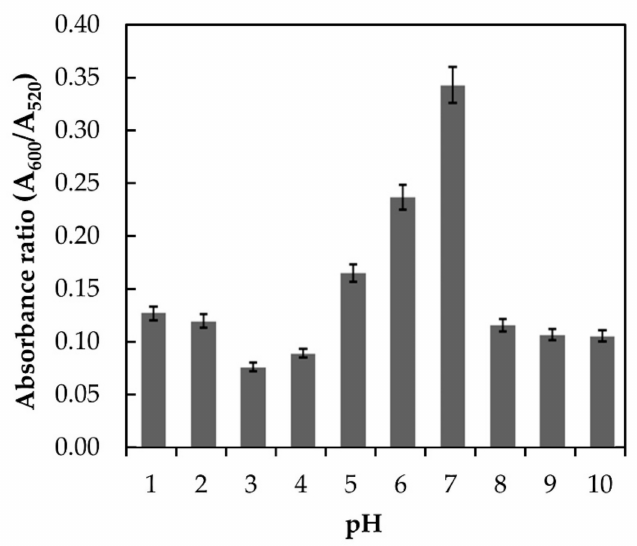
Figure 4. Absorbance of AuNPs in the presence of 9.6 × 10 − 3 M melamine at different pH with absorbance ratios of (A 600 /A 520